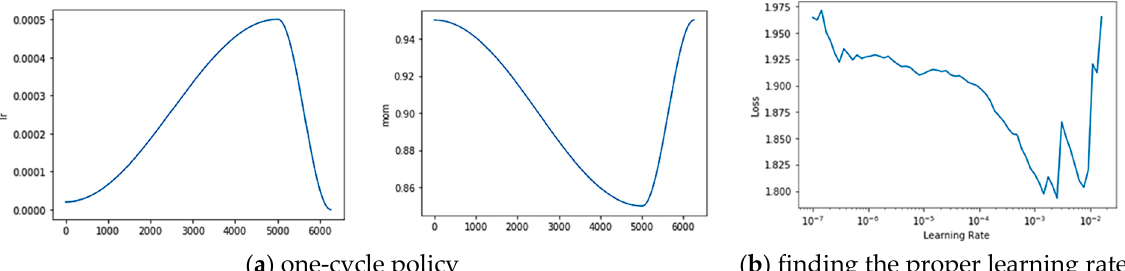
Figure 10. Using the one-cycle policy to find the proper learning rate.